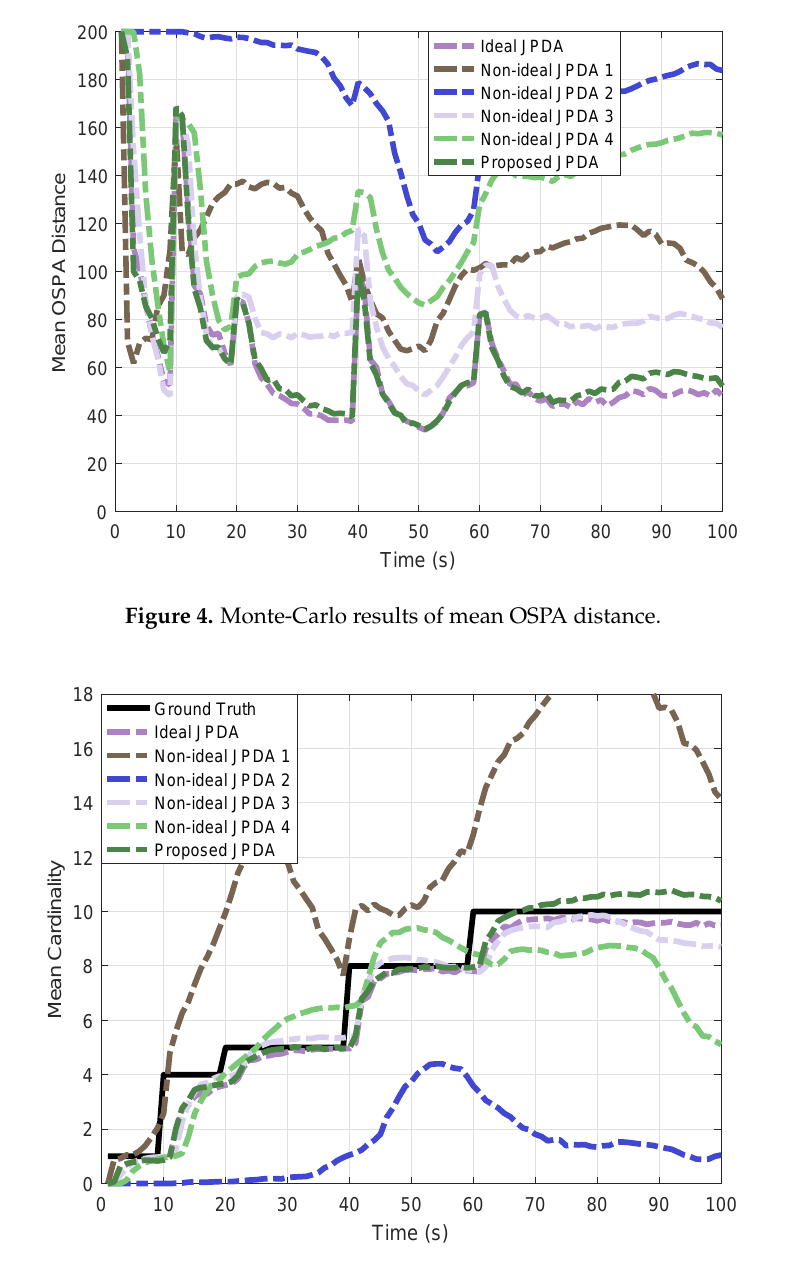
Figure 5. Monte-Carlo results of mean cardinality estimation.